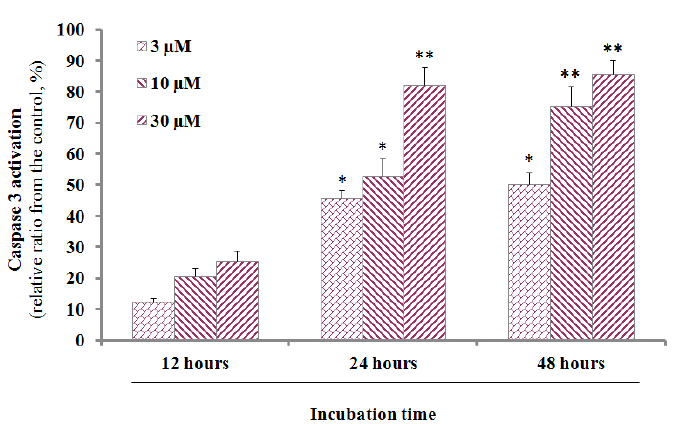
Figure 2. The increment of caspase-3 activity in PANC-1 cells treated by DMC in vitro. After 12 h, 24 h and 48 h incubation with DMC (3–30 μM), the cell lysates were incubated at 37 °C with caspase-3 substrate (Ac-DEVD-AFC) for 1 h. The fluorescence intensity of the cell lysates was measured to determine the caspase-3 activity. The blank group was used as 0.1% DMSO-treated cells. Data are presented as the mean ± SD of results from three independent experiments (* p < 0.01; ** p < 0.05) .